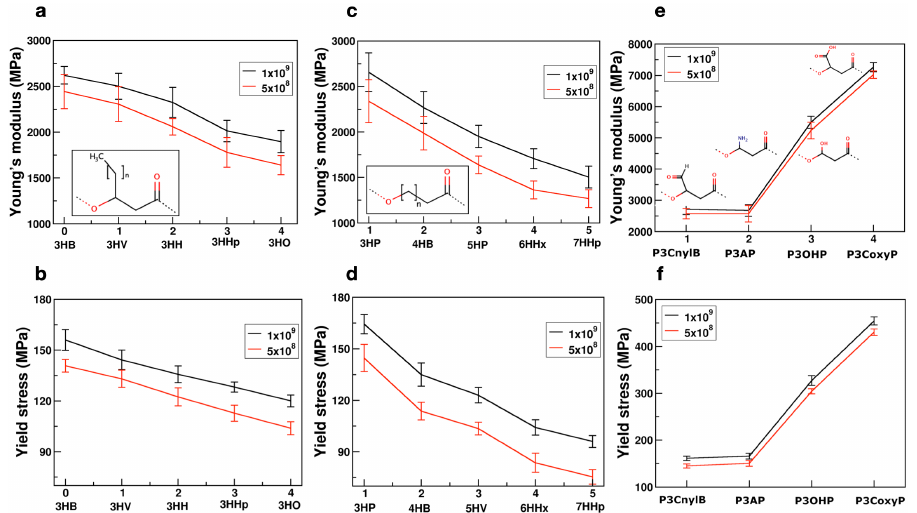
Figure 3. Comparison of Young’s modulus and yield stress values (in MPa) for PHAs with different side chain carbon length ( a , b ), backbone carbon length ( c , d ), and side chain functional group ( e , f ), respectively. Chemical structures of polymers considered in this study are shown in the inset. For each polymer, simulations were performed at 300 K by applying two different strain rates and averaged over 15 independent